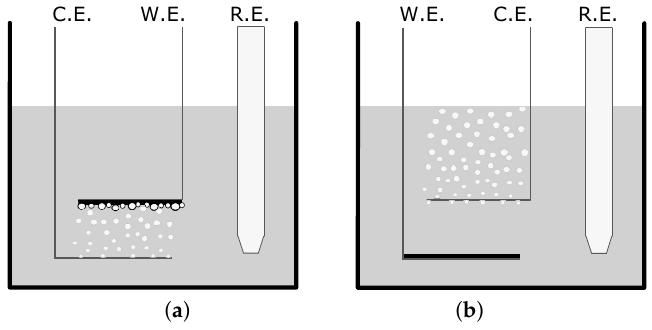
Figure 1. Set-up diagrams depicting the counter electrode (CE), working electrode (WE), and reference electrode (RE) for the creation of ( a ) a microstructured film and ( b ) a flat film in a camphorsulfonic acid/pyrrole solution. The variance in setup allows for the bubble formation and entrapment which creates a variance in surface